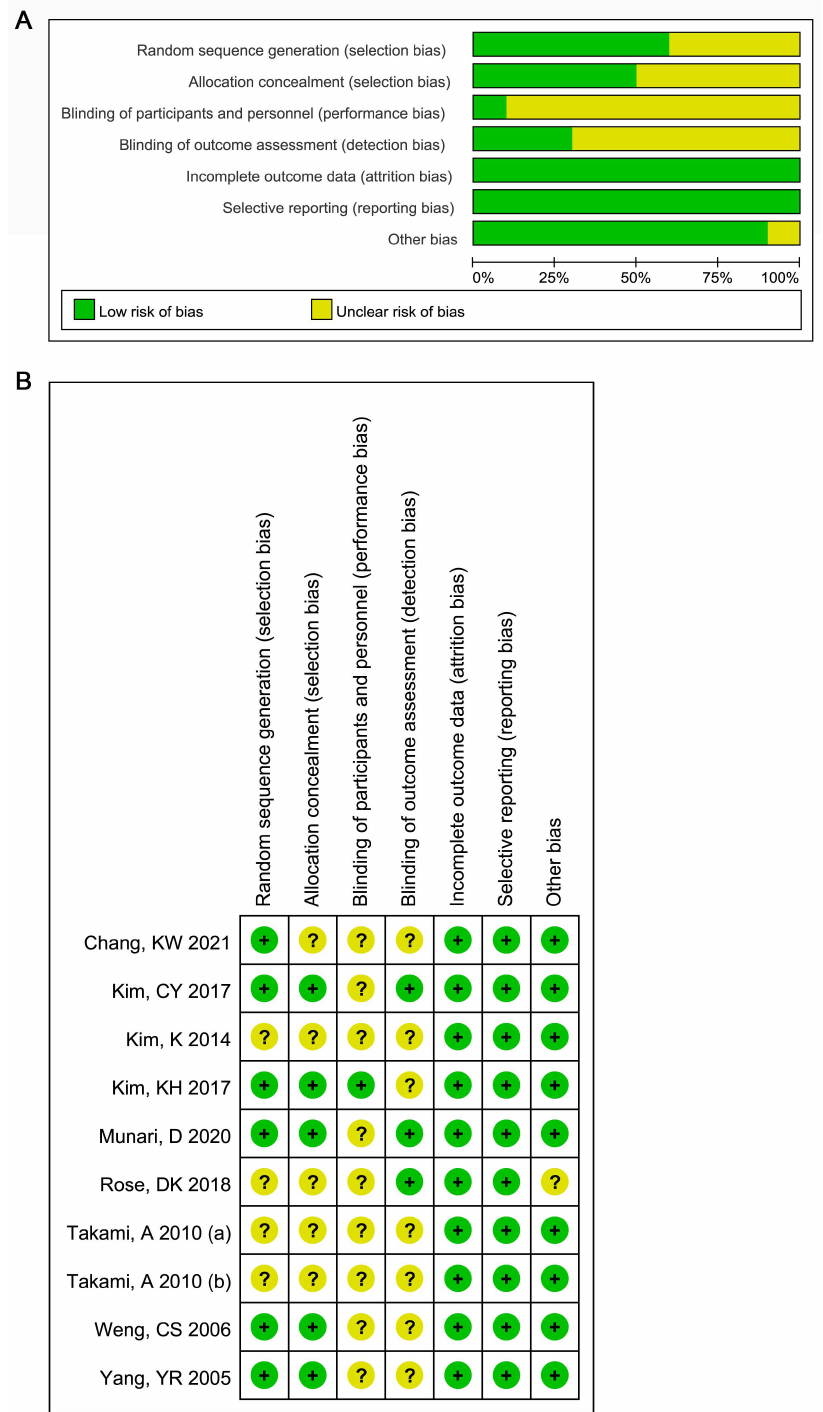
Figure 2. The quality of included studies evaluated by the Cochrane Collaboration’s tool for assessing risk. ( A ) Risk of bias graph; ( B ) risk of bias summary. “+” indicated “Low risk” and “?” indicated